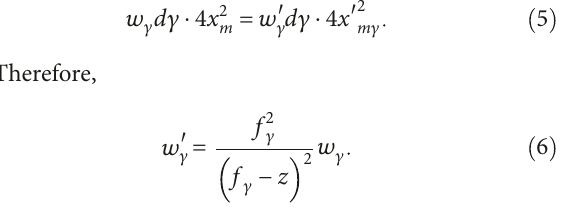
Figure2showstheschematicdiagramofaparallelincident